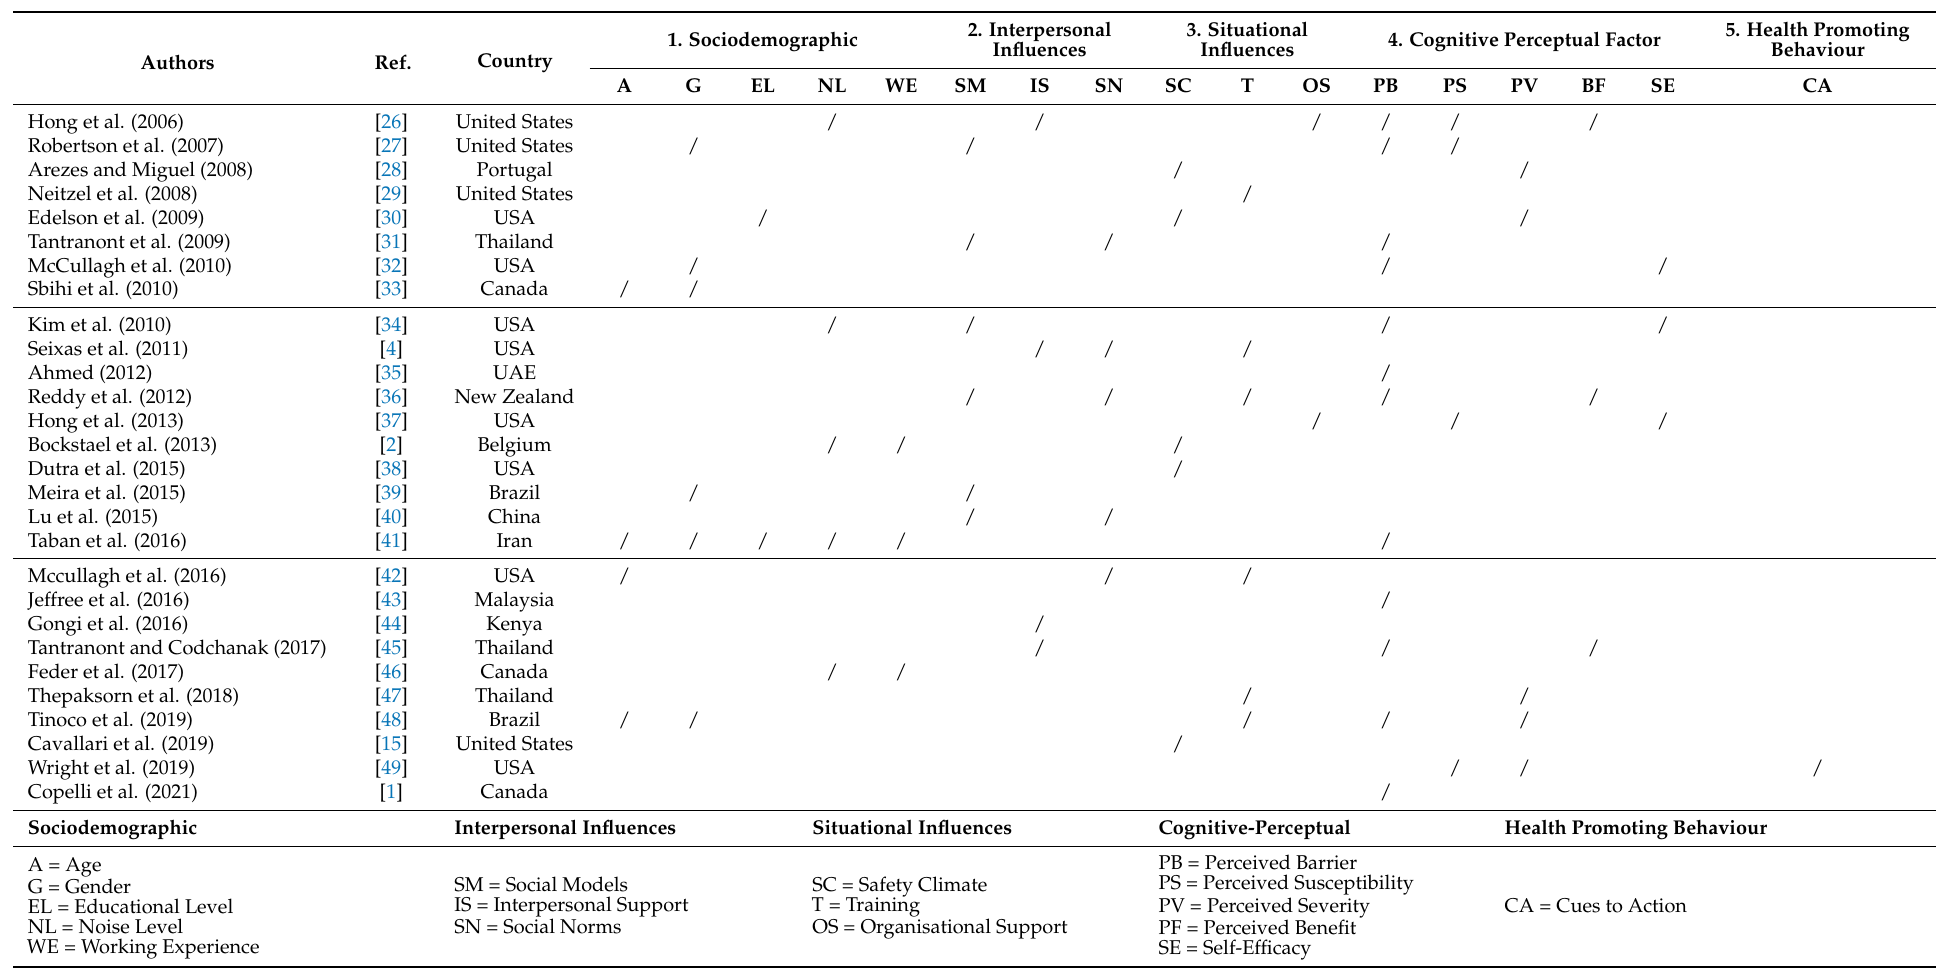
Table 3. Themes and